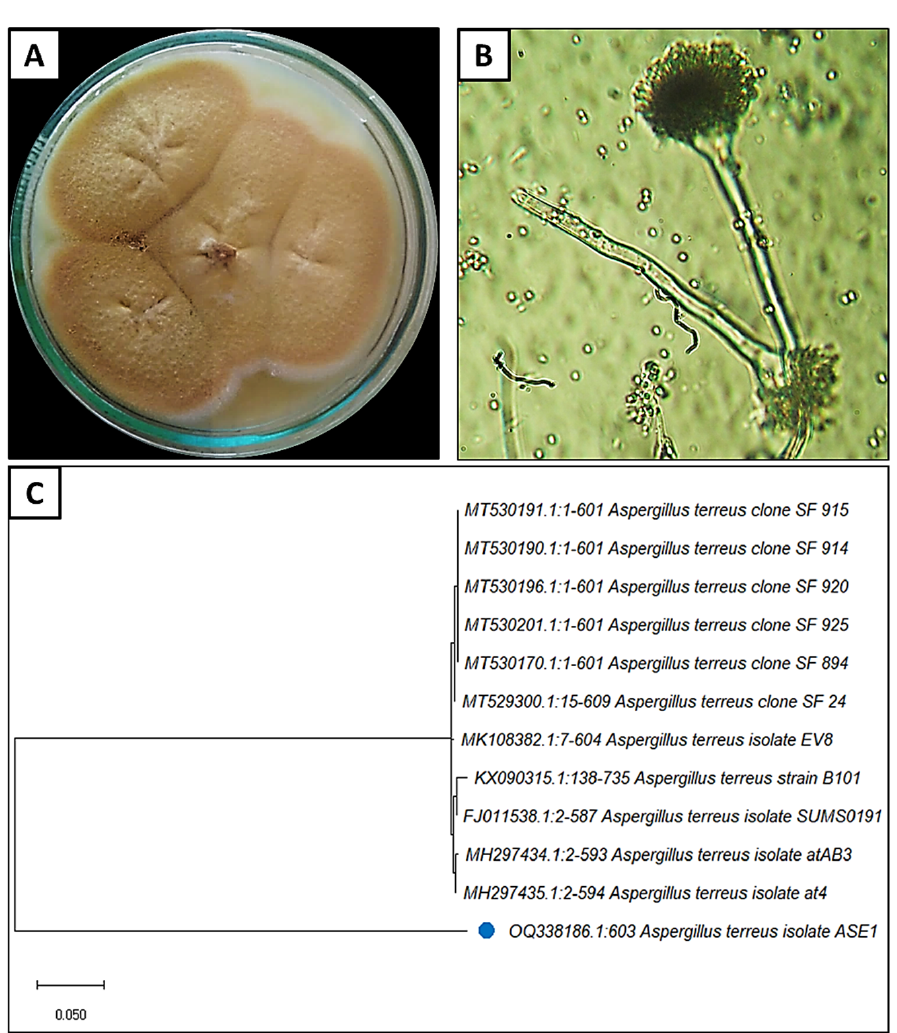
Figure 1. Identification of A. terreus ( A – C ): ( A ) fungus culture on PDA medium; ( B ) head, conidio- phore, and conidia under bright field microscopy; ( C ) phylogenetic tree.